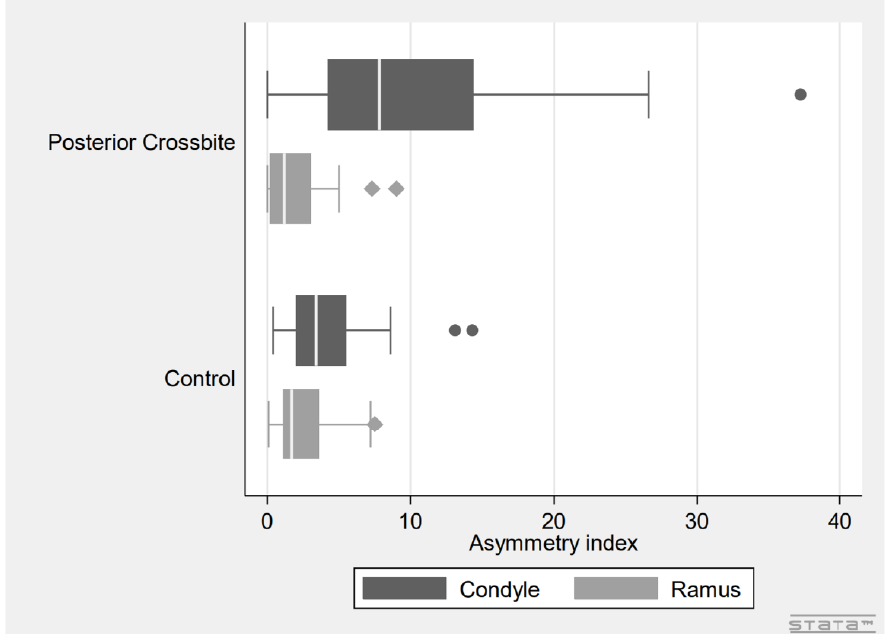
Figure 2. Scatter plots showing the patients’ age on the X -axis and the condylar asymmetry index on the Y -axis. The dot-and-dash line corresponds to a condylar asymmetry index of 6%, the threshold value for asymmetry between the sides. ( A ) unilateral posterior crossbite patients; ( B ) control patients.